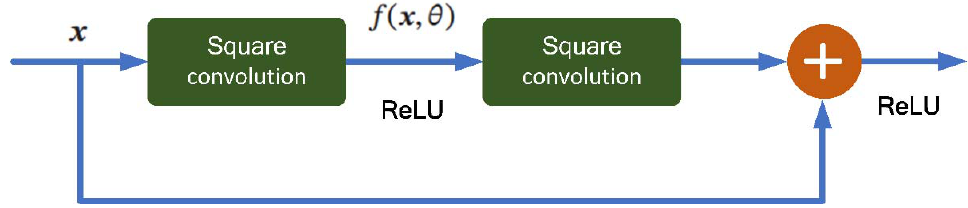
Figure 3. The residual element block structure.